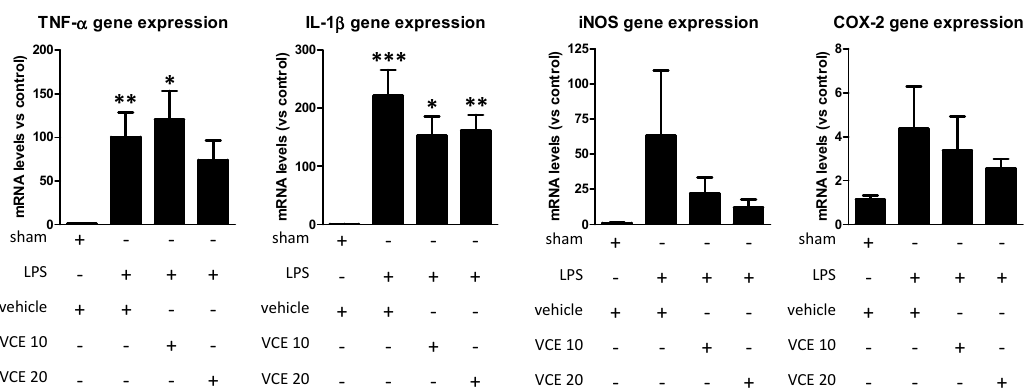
Figure 7. mRNA levels for TNF- α , IL-1 β , iNOS, and COX-2 in the striatum of control and LPS-lesioned mice orally treated for 28 days after lesion with vehicle (corn oil) or VCE-003.2 at the doses of 10 (VCE 10) or 20 (VCE 20) mg / kg. Values were normalized versus control (sham) mice and correspond to means ± SEM of more than six subjects per group. Data were assessed using the one-way analysis of variance followed by the Bonferroni test (* p < 0.05, ** p < 0.01, *** p < 0.005 versus vehicle-treated control (sham) mice).